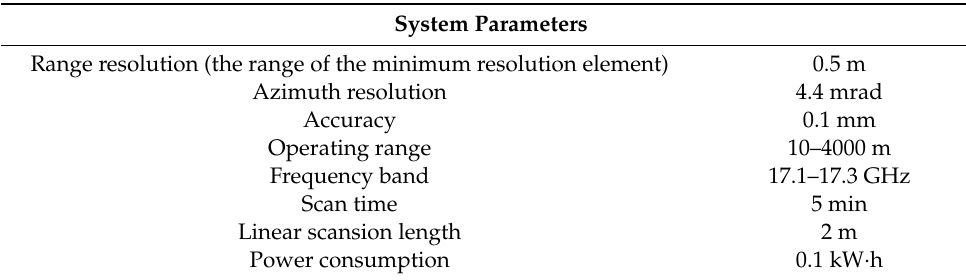
Table 2. The parameters of